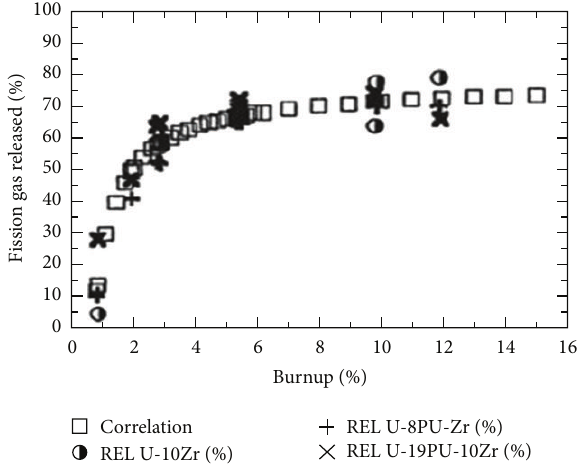
Figure 11: Fission gas releases fraction for metallic